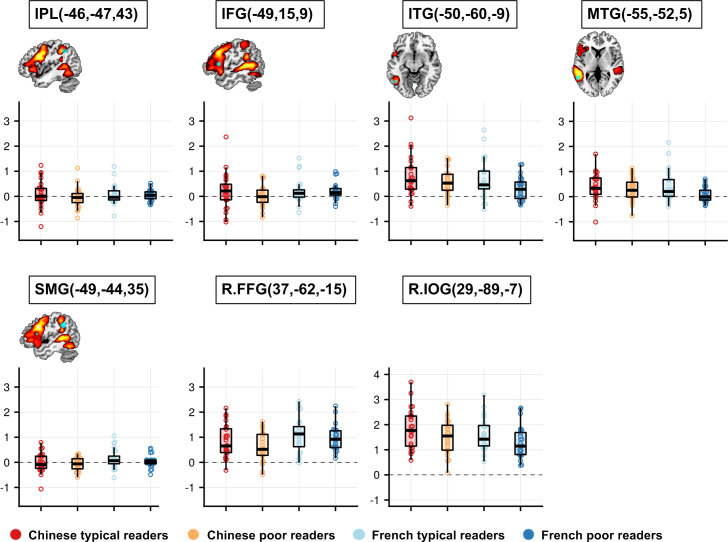
Profile of activation to words (relative to fixation) in ROIs where the ANOVA did not reveal a significant effect.Two ROIs on the right hemisphere (e.g. R.FFG and R.IOG) were not within the reading circuit identified in our participants. Neither the interaction of language × reading ability nor main effect of reading ability or language was found significant in these ROIs.